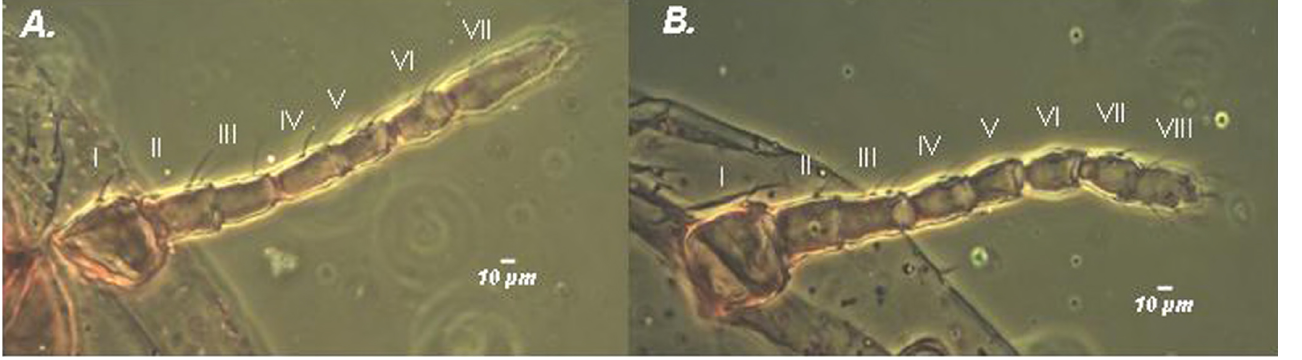
(Figure 2A) but sometimes there are signs of division of the last segment appearing as 8-segmented (Figure 2B); (2) pre-anal abdominal cerarii with groups of 4–8 lanceolate setae (Figure 3); (3) presence of circulus; (4) multilocular disc pores present in dorsal and ventral surface; (5) ostioles represented by the posterior pair only (Figure 4); (6) legs without translucent pores; (7) dorsal oral collars of two sizes (Figure 5); (8) anal lobe cerarii with two conical setae.